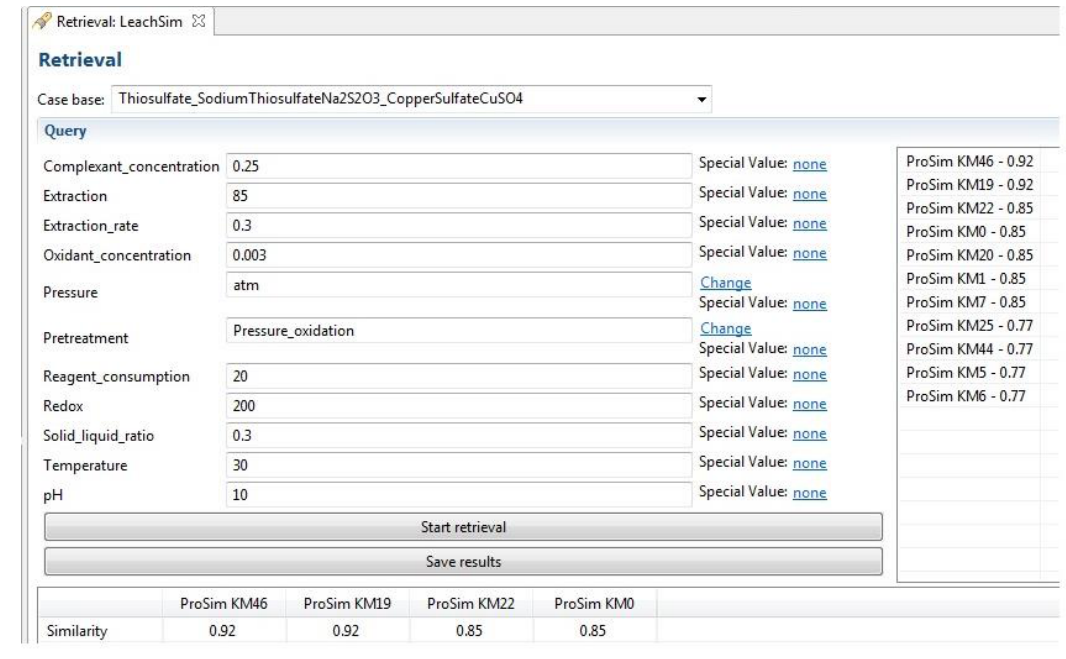
Figure 5. An image of the retrieval function in myCBR with the LeachSim model in place.